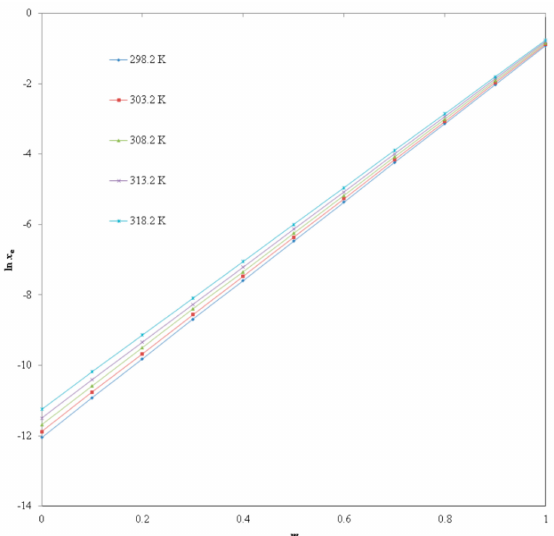
Figure 2. Impact of m value of the DMSO on ln x e values of PPD at five di ff erent temperatures i.e., T = 29.2 K to 318.2 K.